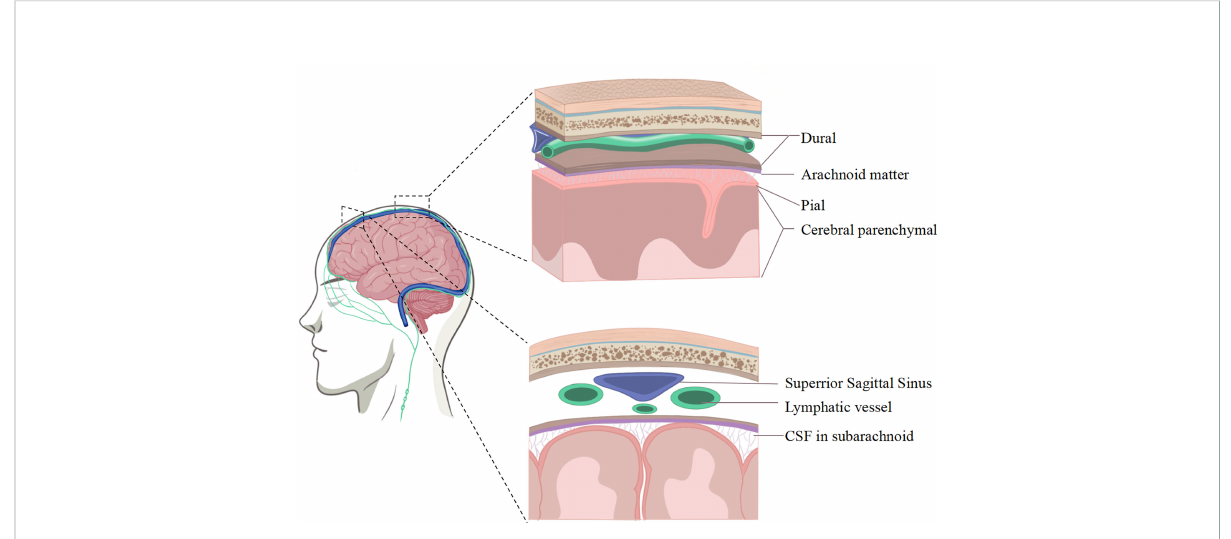
FIGURE 1 Illustration of the meningeal immune